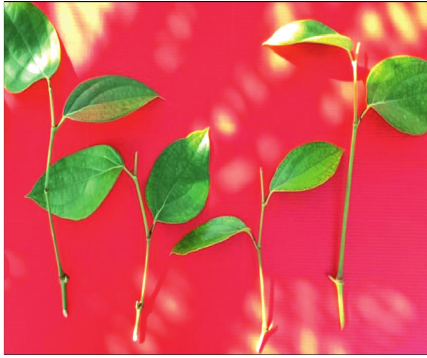
Figure 1: The cuttings used consisted of 2 segments and 2 leaves of Natar 1